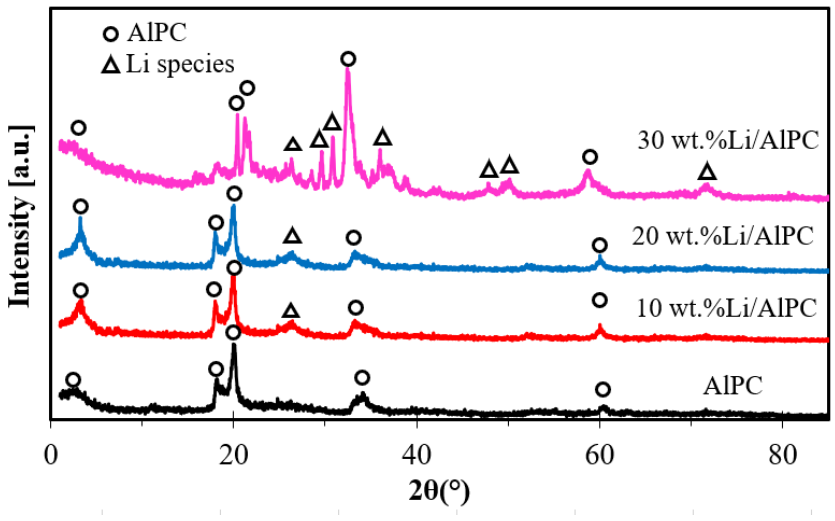
Figure 3. XRD patterns of AlPC and x wt.%Li/AlPC ( x = 10, 20 and 30 wt.%) catalysts.